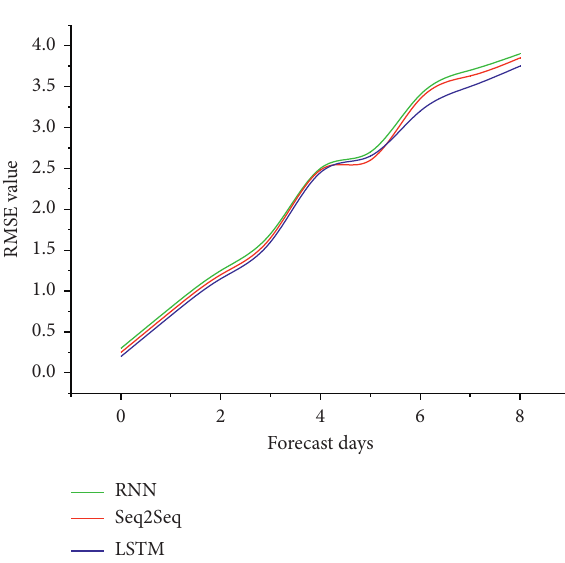
Figure 7: Network prediction results.